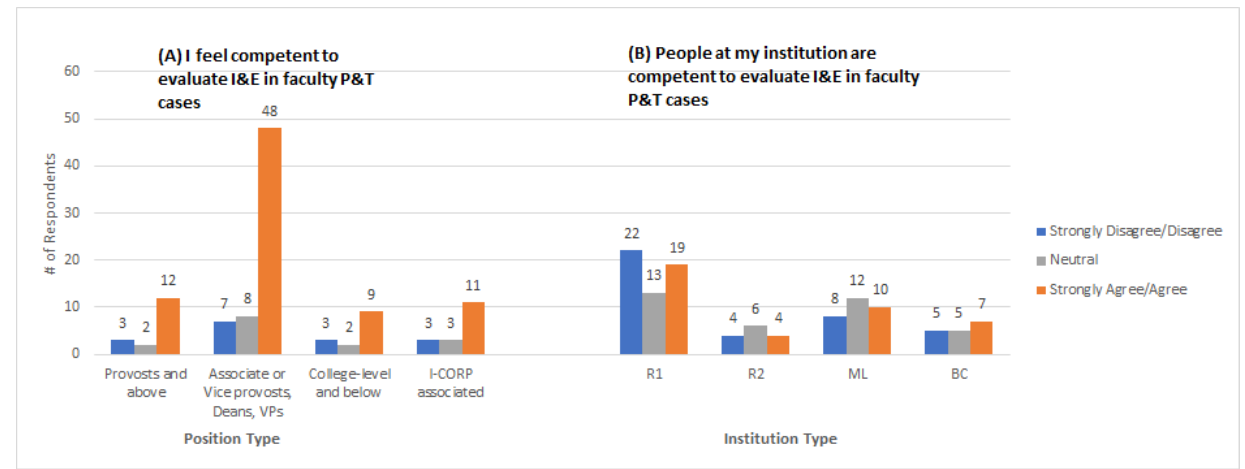
Figure 7. Comparison of felt competencies by position types in evaluating faculty members’ I&E when considering P&T cases ( A ) and the same sample by institution types, the degree to which they felt others at their institutions possessed this competency ( B ).